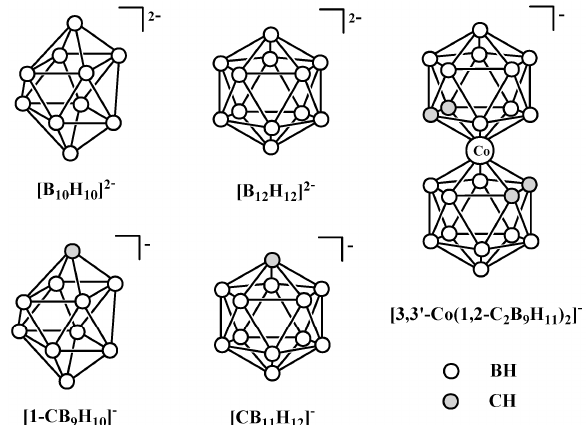
Figure 3. Anionic polyhedral boron hydrides discussed by Avdeeva et al. in reference [16]. Reproduced with permission from reference [16], published by MDPI, 2016.